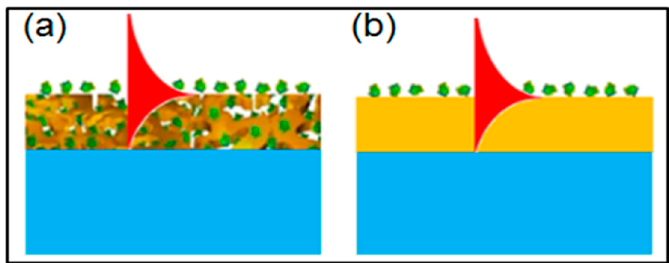
Figure 8. Schematic diagram showing the difference in evanescent wave interaction with adsorbed molecules between ( a ) the NPG film and ( b ) the dense gold film.